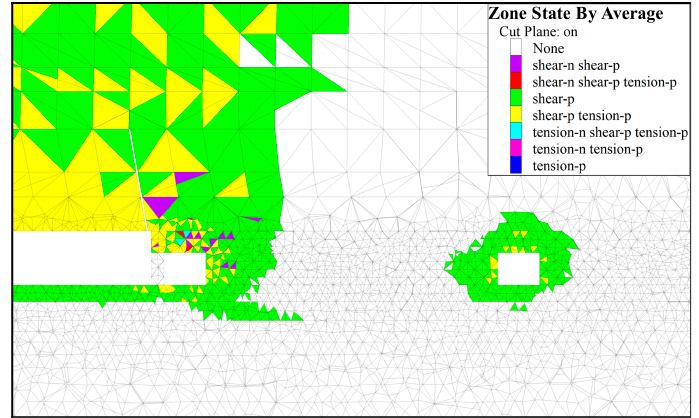
Figure 17. Plastic development of surrounding rocks after roof-cutting reinforcement.